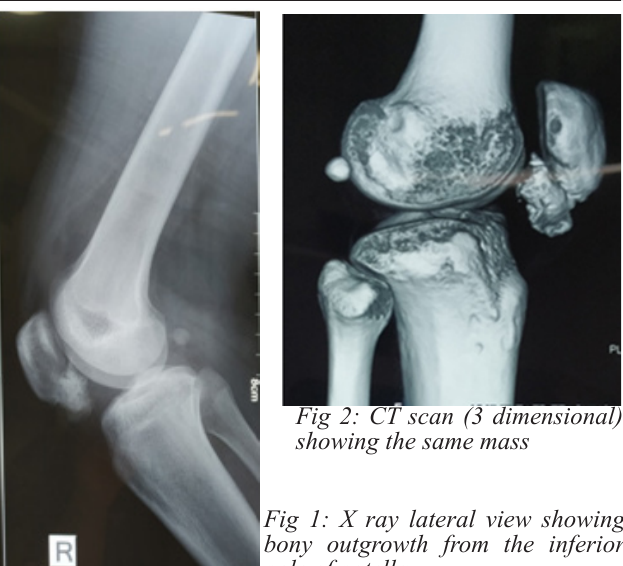
Fig 2: CT scan (3 dimensional) showing the same mass Fig 1: X ray lateral view showing bony outgrowth from the inferior pole of